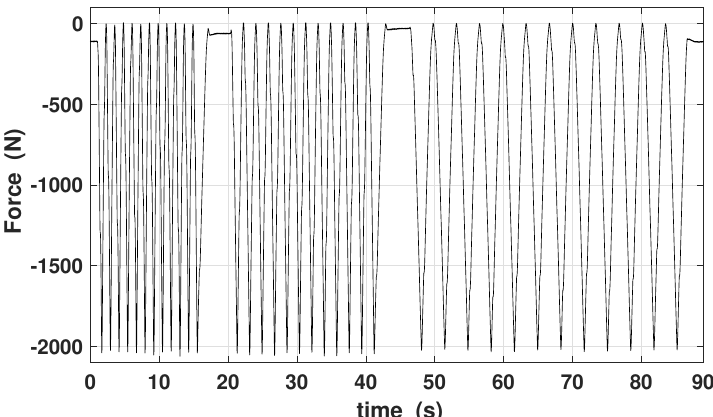
Figure 9. Force profile applied to the 3-rod KEH device. It consists in ten compressive cycles from 0 to − 2000 N at different UTM speeds—150, 100, 50 mm/min.